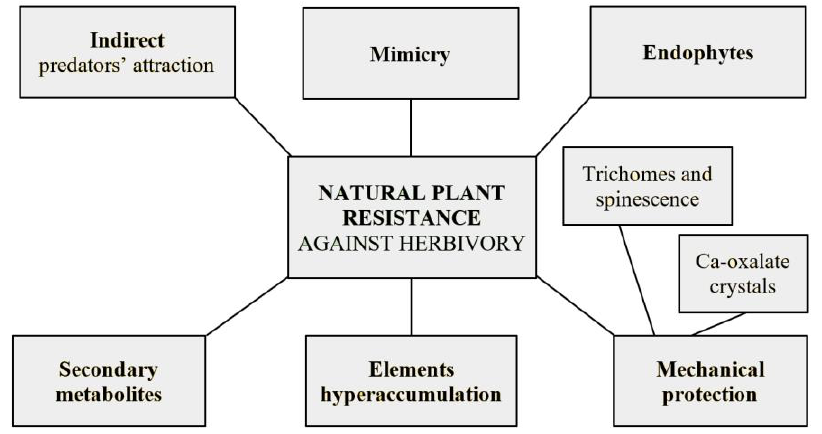
Figure 1. Natural methods of plant resistance against herbivories.